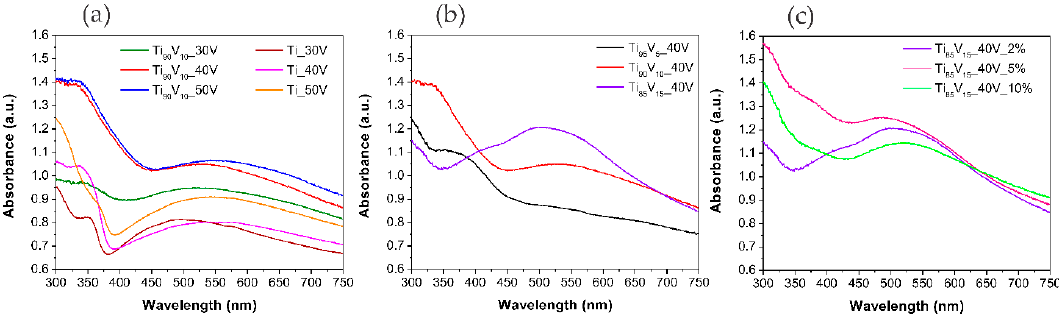
Figure 4. UV-Vis spectra of pristine TiO 2 NTs and V 2 O 5 -TiO 2 nanostructures (NS). Effect of ( a ) anodization potential; ( b ) vanadium content in the alloy; and ( c ) water content in the electrolyte.